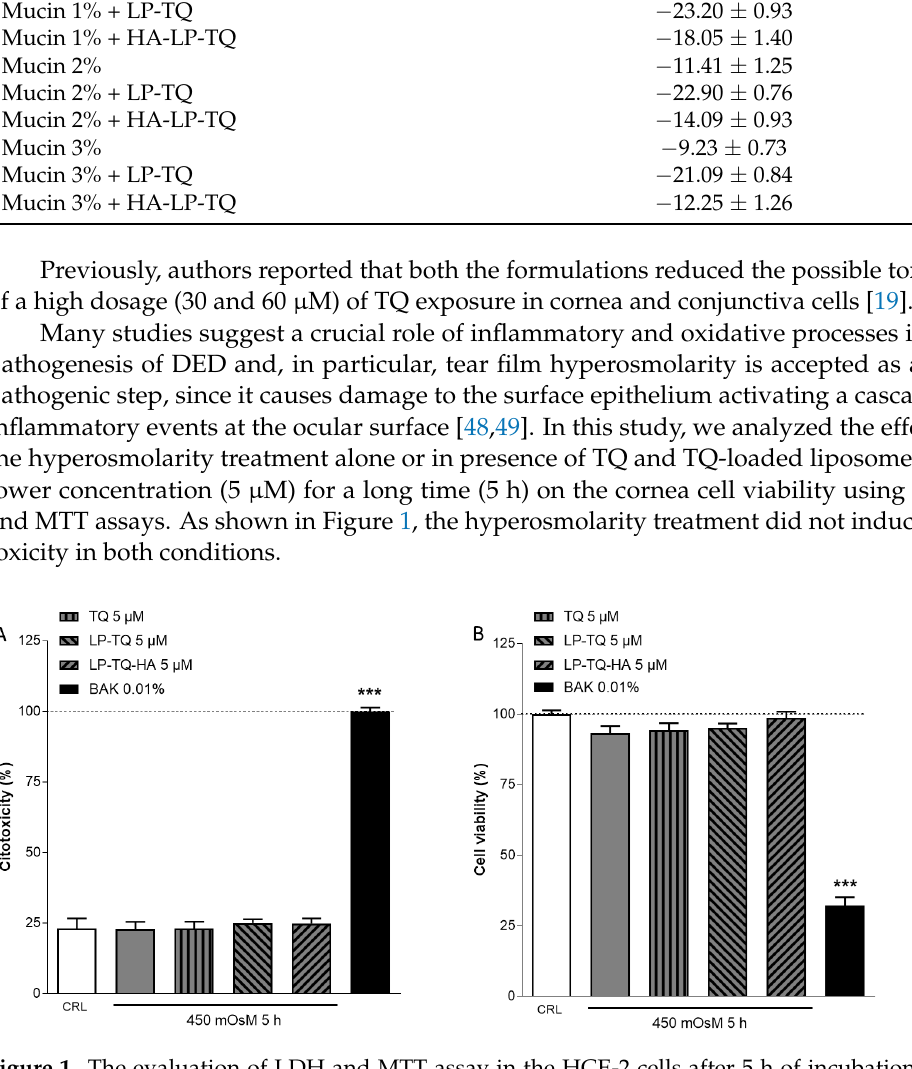
Figure 1. The evaluation of LDH and MTT assay in the HCE-2 cells after 5 h of incubation with hyperosmolarity media alone, or in the presence of TQ, LP-TQ or LP-TQ-HA. Data are expressed as percentages of the maximum degree of cell death BAK 0.01% ( A ) and as percentages of maximum cell viability (medium) ( B ); they represent the mean ± SEM of the mean of at least three experiments performed in quadruplicate. *** p < 0.001 vs. CRL (one-way ANOVA plus